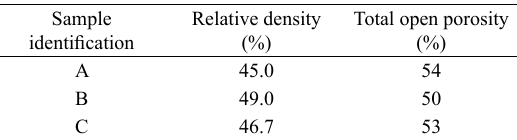
Figure 2. Relative density and apparent porosity in function of sintering temperature Table 2. Relative density and total open porosity of samples sintered at 1350°C